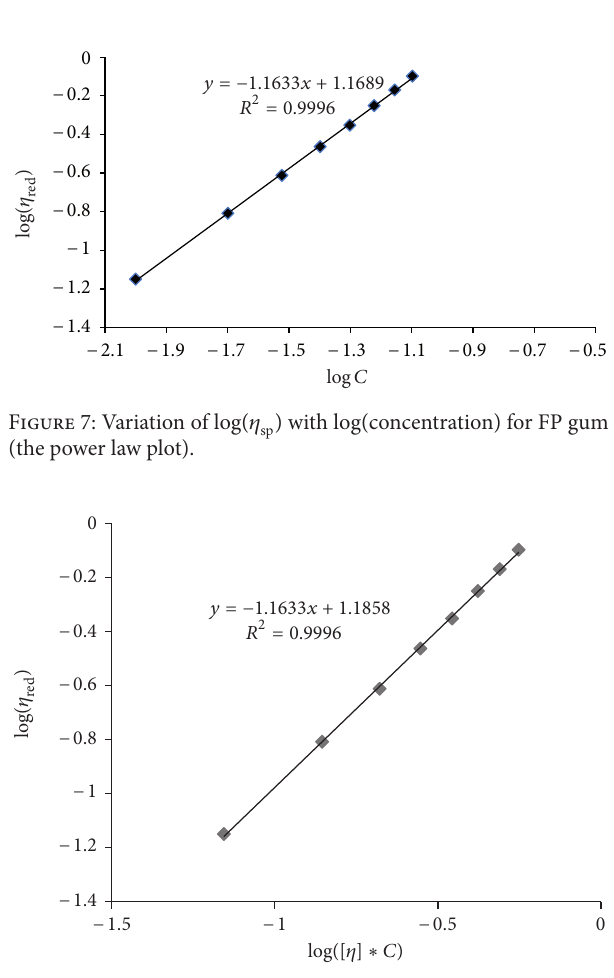
F 8: Double log plot for the variation of for FP gum (e master’s curve). 𝐶𝐶)